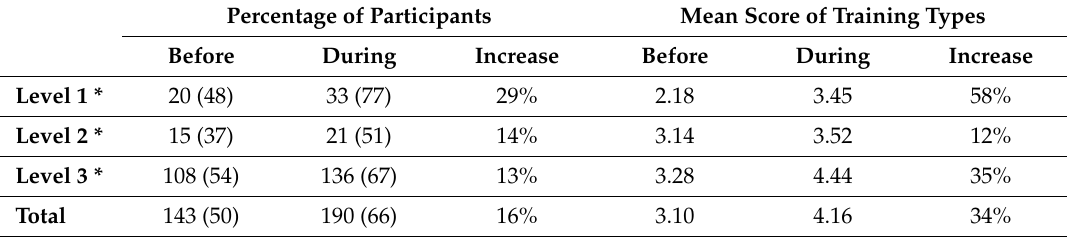
Table 3. Frequency and proportion ( n (%)) of participants taking part in management related training before taking up and during their current management positions by hospital, and mean scores of training types completed by hospital. Percentage of Participants Before Before